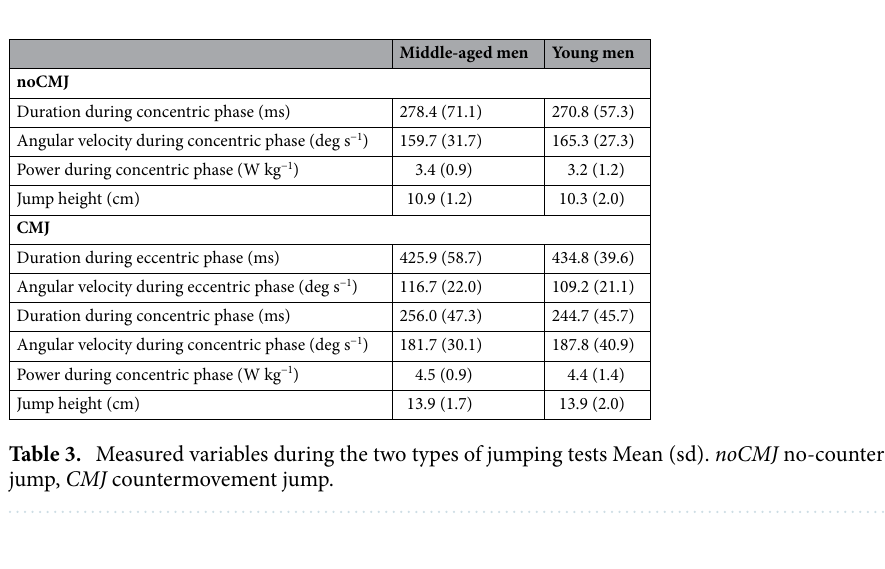
Figure 4. Relationship between %MVC and elongation of tendon structures during ramp (left: A , C ) and ballistic (right: B , D ) contractions in middle-aged (upper: A , B ) and young (lower: C , D ) men. Data are mean ± SD.